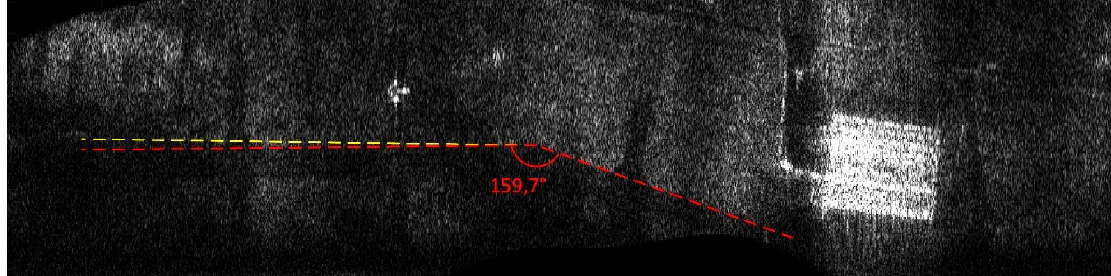
Figure 16. Radar terrain image obtained with the use of INS data; yellow line—a north edge of the taxiway.